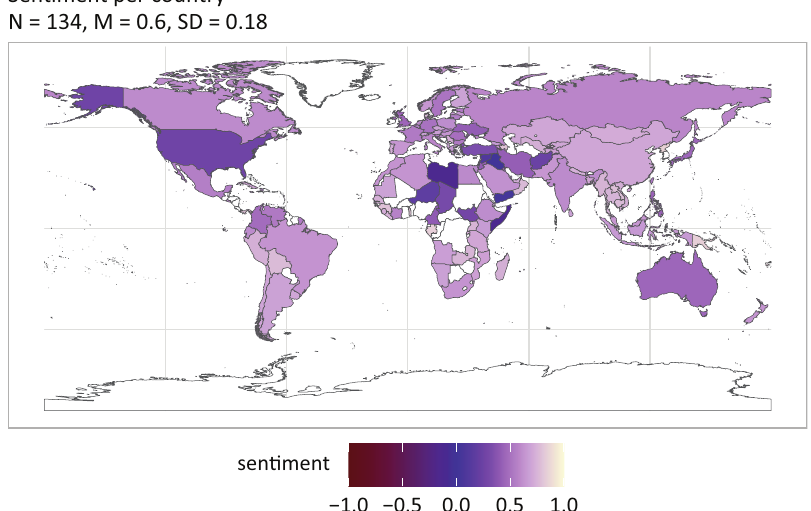
Figure 9. Average sentiment per country. Note: Like in domestic news, no country has an average negative sentiment score, but there is much more variation than at the domestic